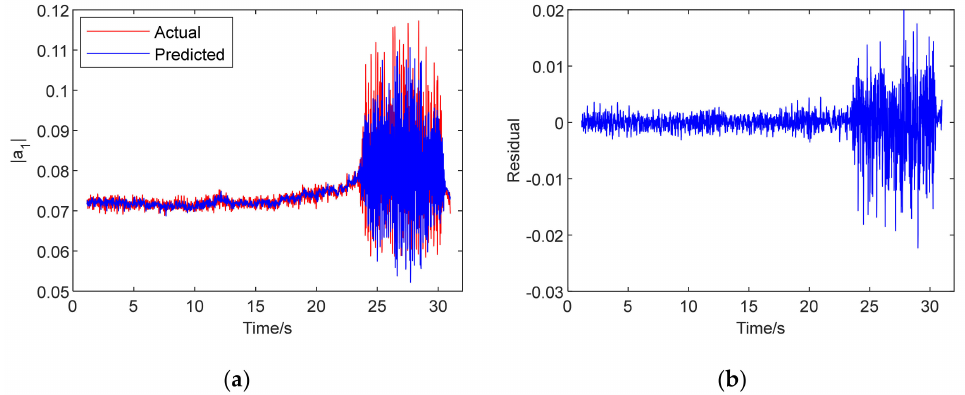
Figure 14. Multi-step prediction results: ( a ) prediction; ( b ) residual.